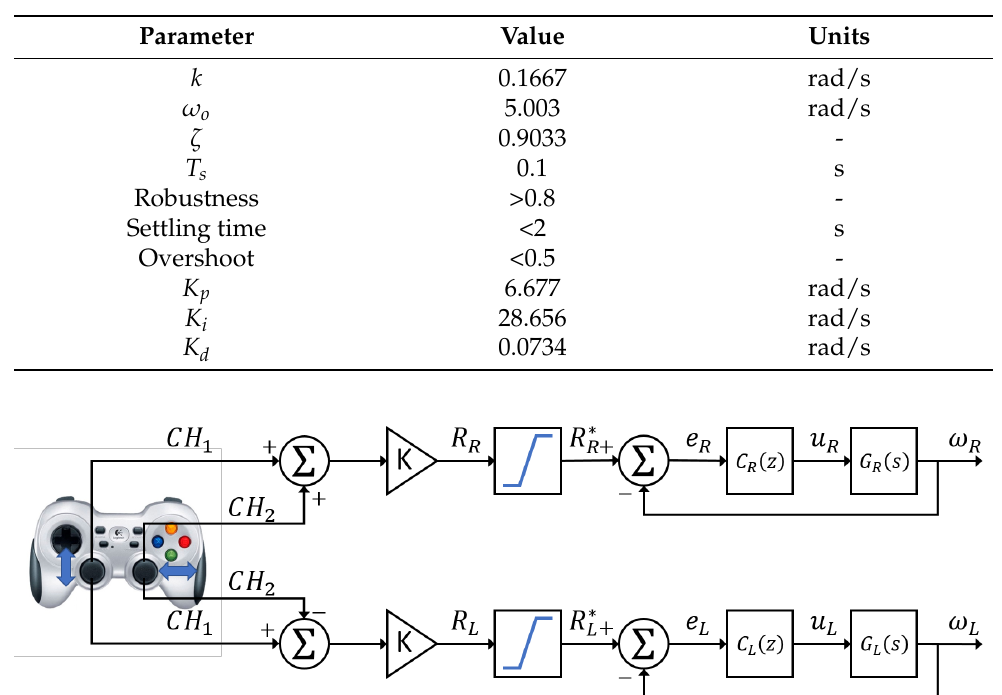
Table 4. Design parameters for wheel speed controllers.